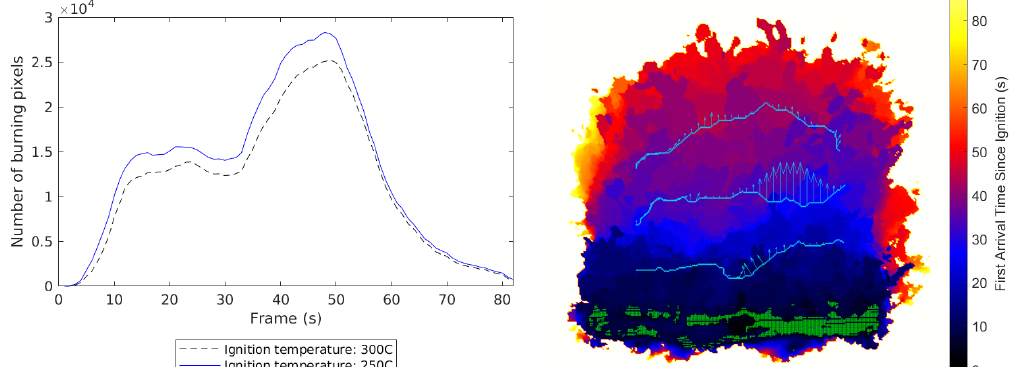
Figure 15. ( Left ): The number of burning pixels, defined using two different ignition temperatures, as a function of time. ( Right ): The per-pixel time of ignition (first arrival time) of the 2 m × 2 m linear spread plot described in Section 2. The green points correspond to manual ignition positions at time t = 0 s. The three sets of blue points are isotherms calculated at t = 20 s (lower), t = 30 s (middle), and t = 47 s (upper). Plotted alongside each isotherm are several corresponding velocity